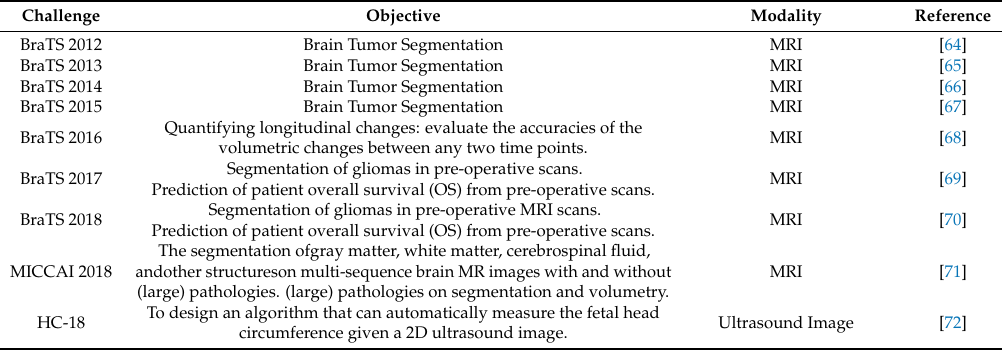
Table 4. Overview open challenges of brain image analysis worldwide.